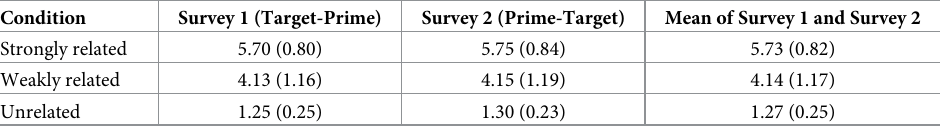
Table 3. Mean ratings and standard deviations (in parentheses) for the three conditions in Survey 1 and Survey